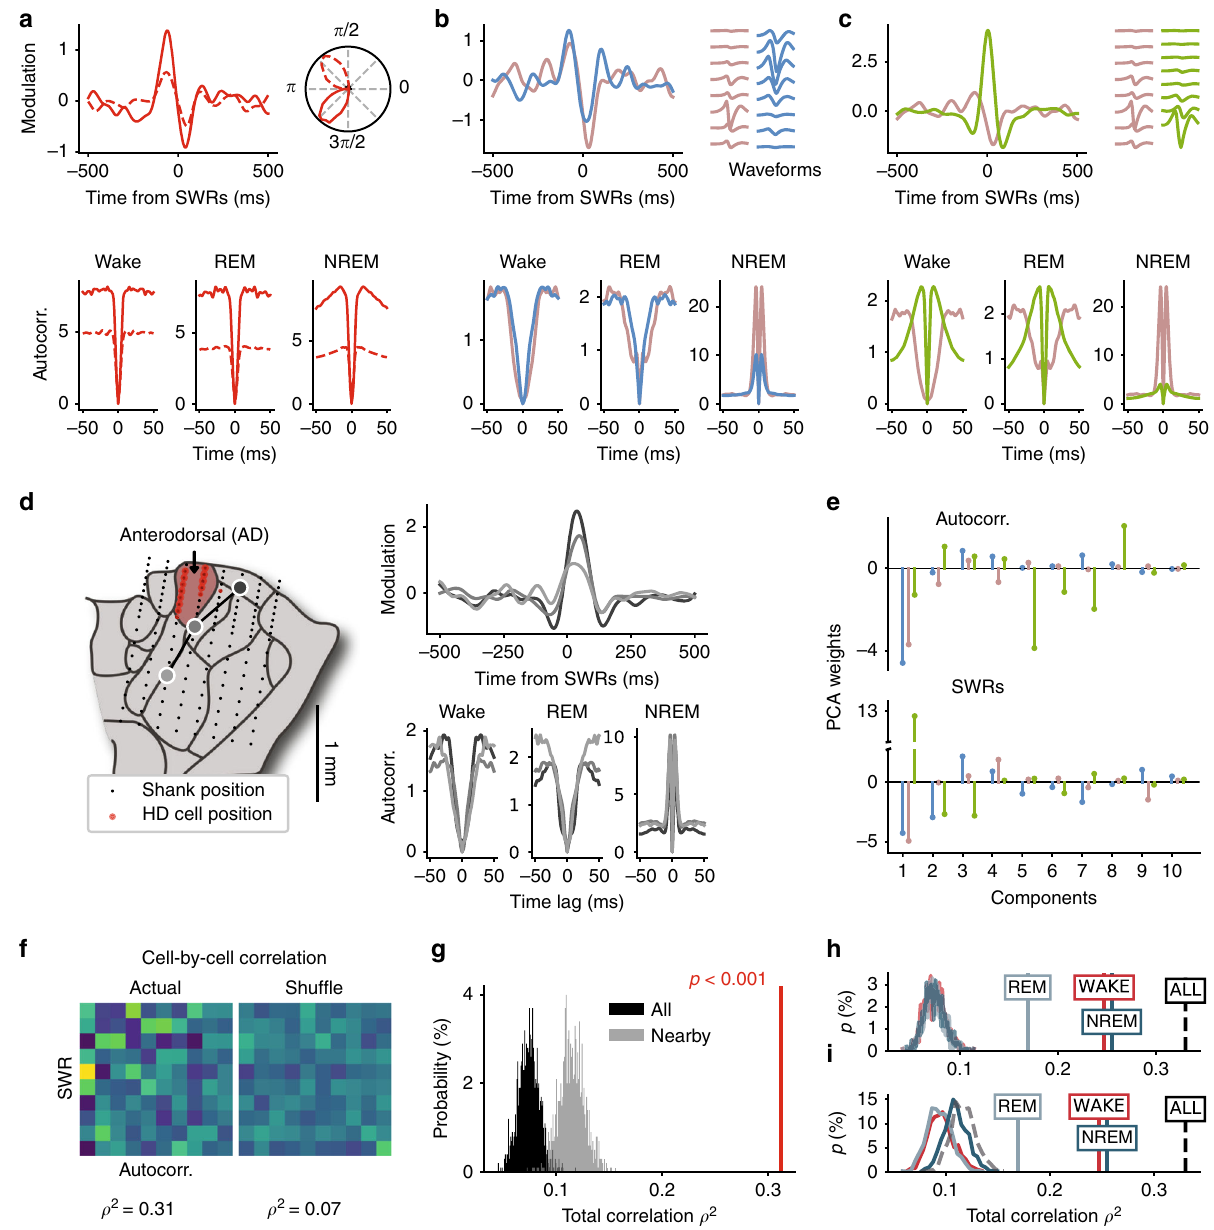
Fig. 4 Covariation between single-cell spike train auto-correlograms and SWR cross-correlograms. a SWRs cross-correlograms (top left) and auto- correlograms across brain states (bottom) for two example HD neurons. Circular plots (top right) indicate HD tuning curves. b , c Same as a for three non- HD neurons recorded simultaneously on the same shank. Top right, average waveforms on the eight recording sites of the shank, from dorsal (top) to ventral (bottom) positions. The neuron shown in gray is the same for both panels. Note that, although the cell bodies of the two neurons in c are close to each other (see waveforms), auto-correlograms and responses to SWRs are strikingly different. d Same as a – c but for three neurons recorded on different shanks and different sessions in the same animal. Their anatomical location is shown on the left-side map of the anterior thalamus. e PCA projections of fi rst 20ms of auto-correlograms (top) and SWR cross-correlograms (bottom) for the three example neurons of b , c . f Correlation matrix between the two series of PCA weights (left) and for shuf fl ed neuronal identities (right) for all neurons. ρ 2 : total correlation. g Distribution of total correlation ρ 2 for actual (red line) and for random shuf fl ing of cell identities (1000 times) between all cells irrespective of shank and recording days (black) and between cells recorded on the same shank on a given day (gray). h Distribution of total correlation ρ 2 for actual (vertical lines) and shuf fl ed data between SWRs and auto-correlograms from wake (red), REM sleep (light blue) and NREM sleep (dark blue). Dashed line shows correlation between SWRs and stacked auto- correlograms of all epochs (same as in g ). i Same as h but for cell identities shuf fl ed within